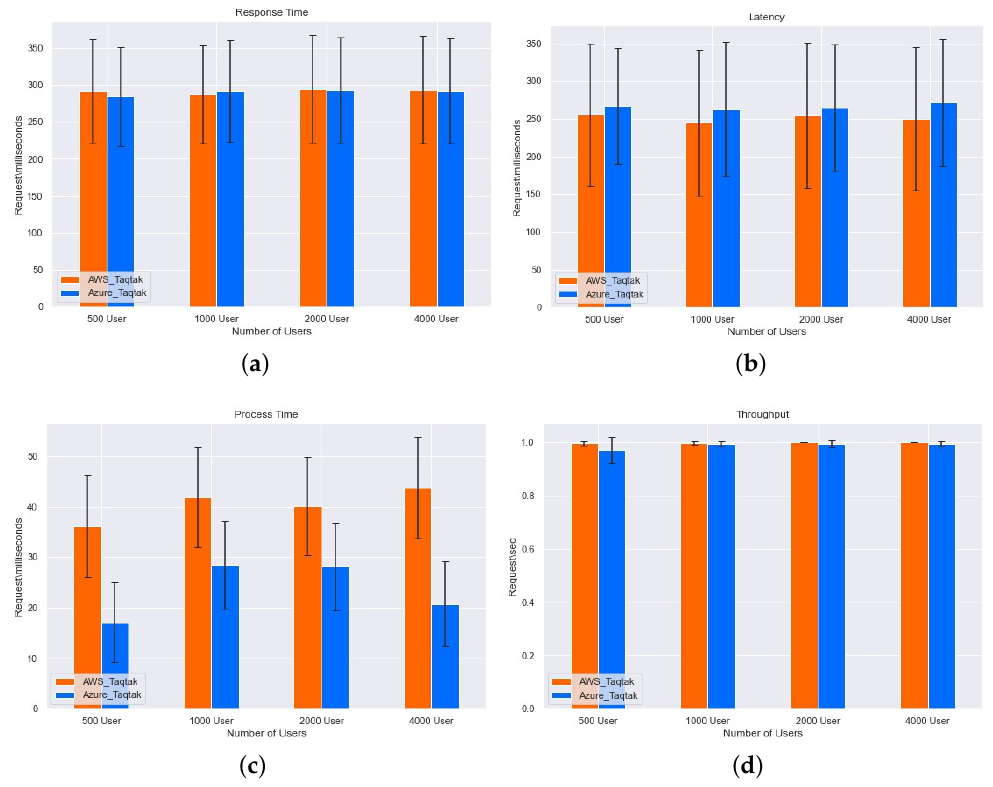
Figure 5. Comparison of the professional service category API on the two cloud platforms. ( a ) Re- sponse time of the TaqTak API. ( b ) Latency of the TaqTak API. ( c ) Processing time of the TaqTak API. ( d ) Throughput of the TaqTak